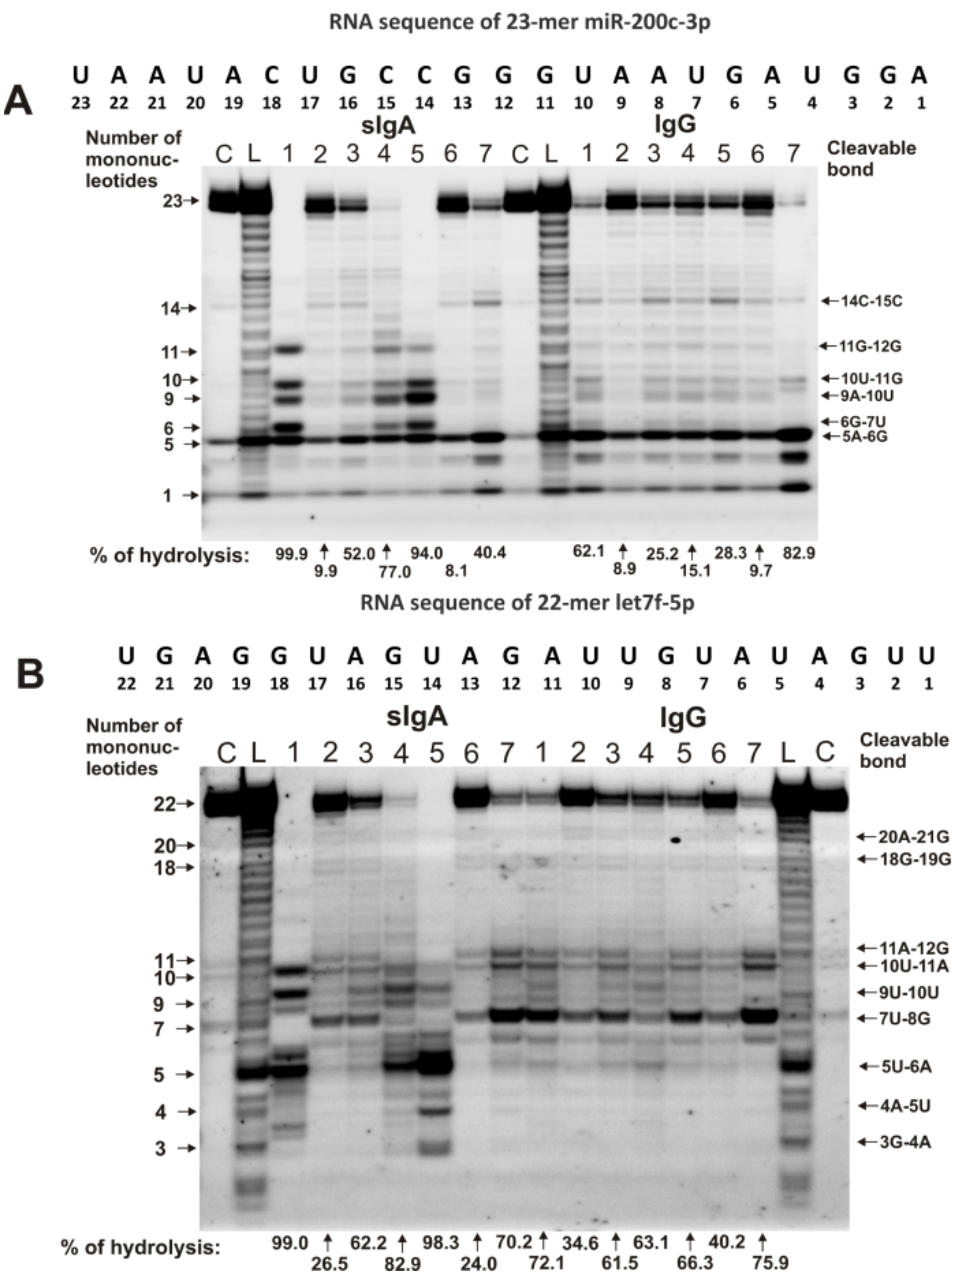
Figure 2. The patterns of 0.01 mg/mL Flu-miR-200c-3p ( A ) and Flu-let-7f-5p ( B ) hydrolysis by sIgAs and IgGs (0.04 mg/mL) from human milk plasma. The hydrolysis products were detected due to the fluorescent residue (Flu) on microRNAs’ 5 ′ -ends after reaction mixture incubation for 1 h. The numbers of sIgAs and IgGs, lengths of the splitting products, and the percentages of hydrolysis of two microRNAs by each antibody preparation, are indicated in panels ( A , B ).